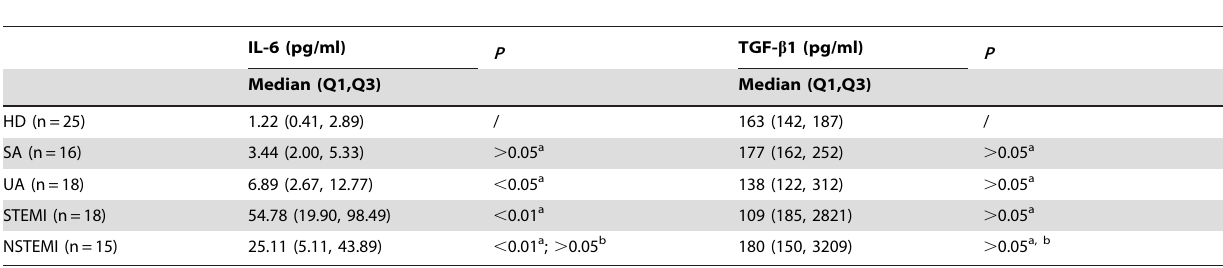
Table 3. Concentrations of serum IL-6 and TGF- b 1 in ACS patients and